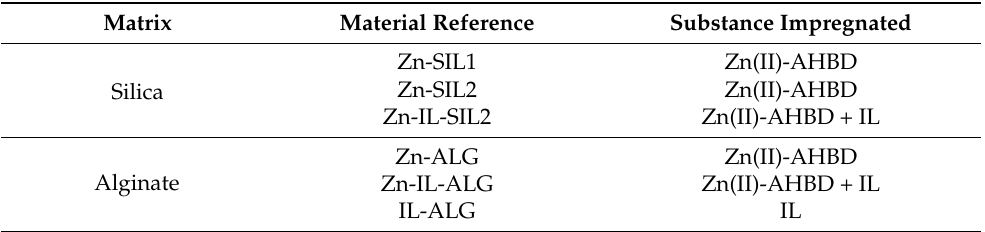
Table 1. Impregnated silica (SIL) and alginate (ALG) aerogels prepared by the wet impregnation method.